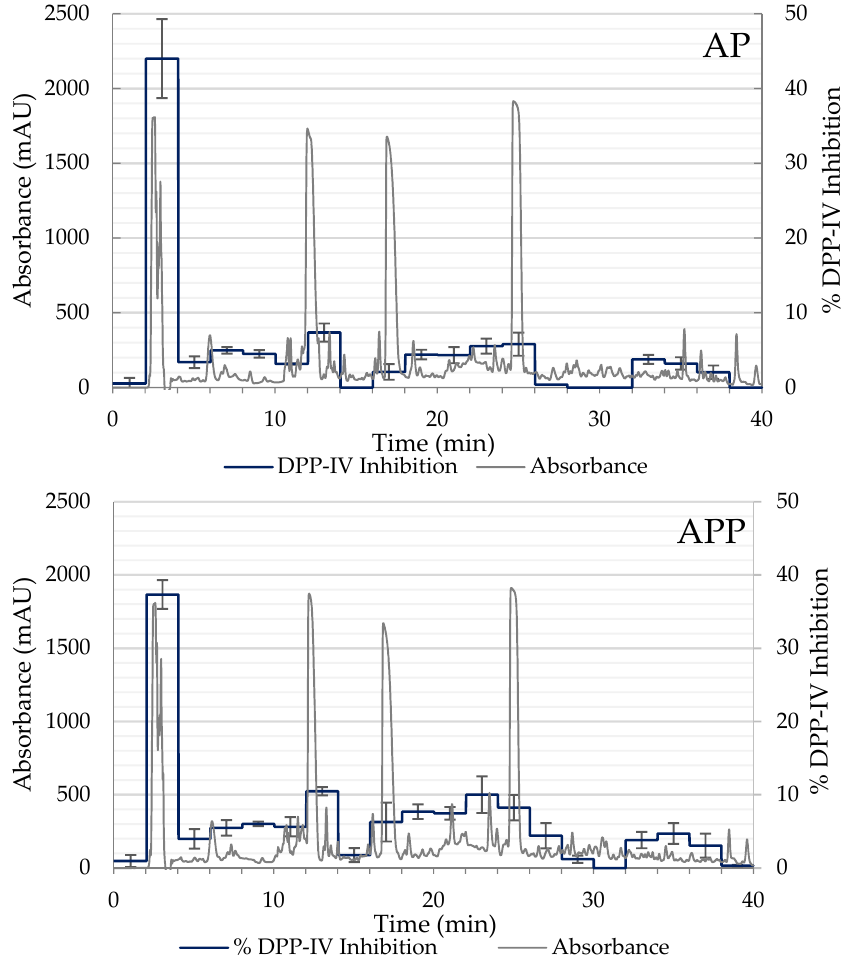
Figure 3. Elution profile and DPP-IV inhibition rate of the peptide fractions of the hydrolysates AP (2% Alcalase + 5% Protana Prime) and APP (2% Alcalase + 5% Protana Prime + 3% Protana UBoost) separated by RP-HPLC. The inhibition rate of DPP-IV was determined with each fraction at a concentration of 100 mg/mL hydrolysate.